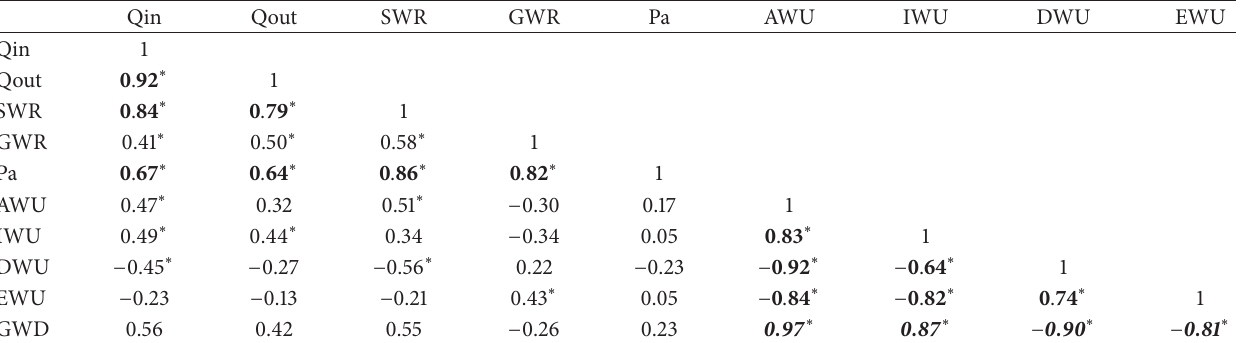
Table 4: Correlation coefficient of groundwater depth and its predictors.